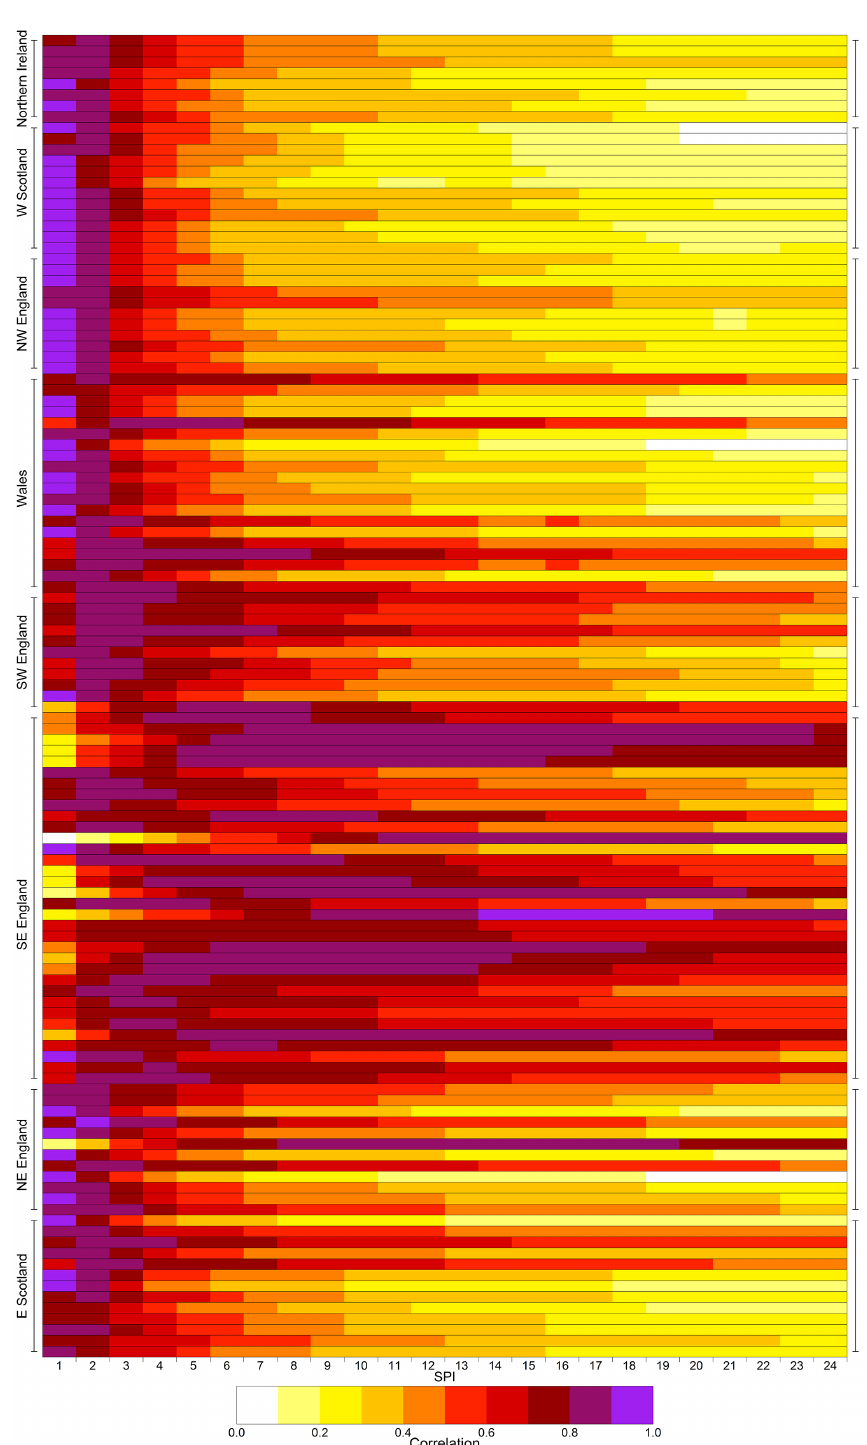
Figure 9. Heat map showing correlations of SPI accumulation periods of 1–24 months with SSI-1 for all catchments.